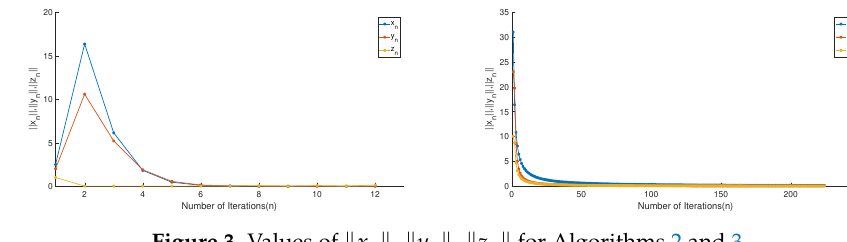
Figure 3. Values of (cid:107) x n (cid:107) , (cid:107) y n (cid:107) , (cid:107) z n (cid:107) for Algorithms 2 and 3.